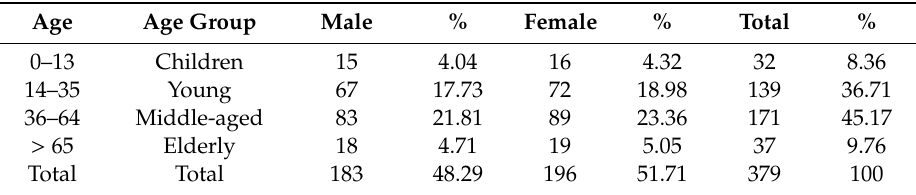
Table 2. Statistics of di ff erent age and gender groups in the